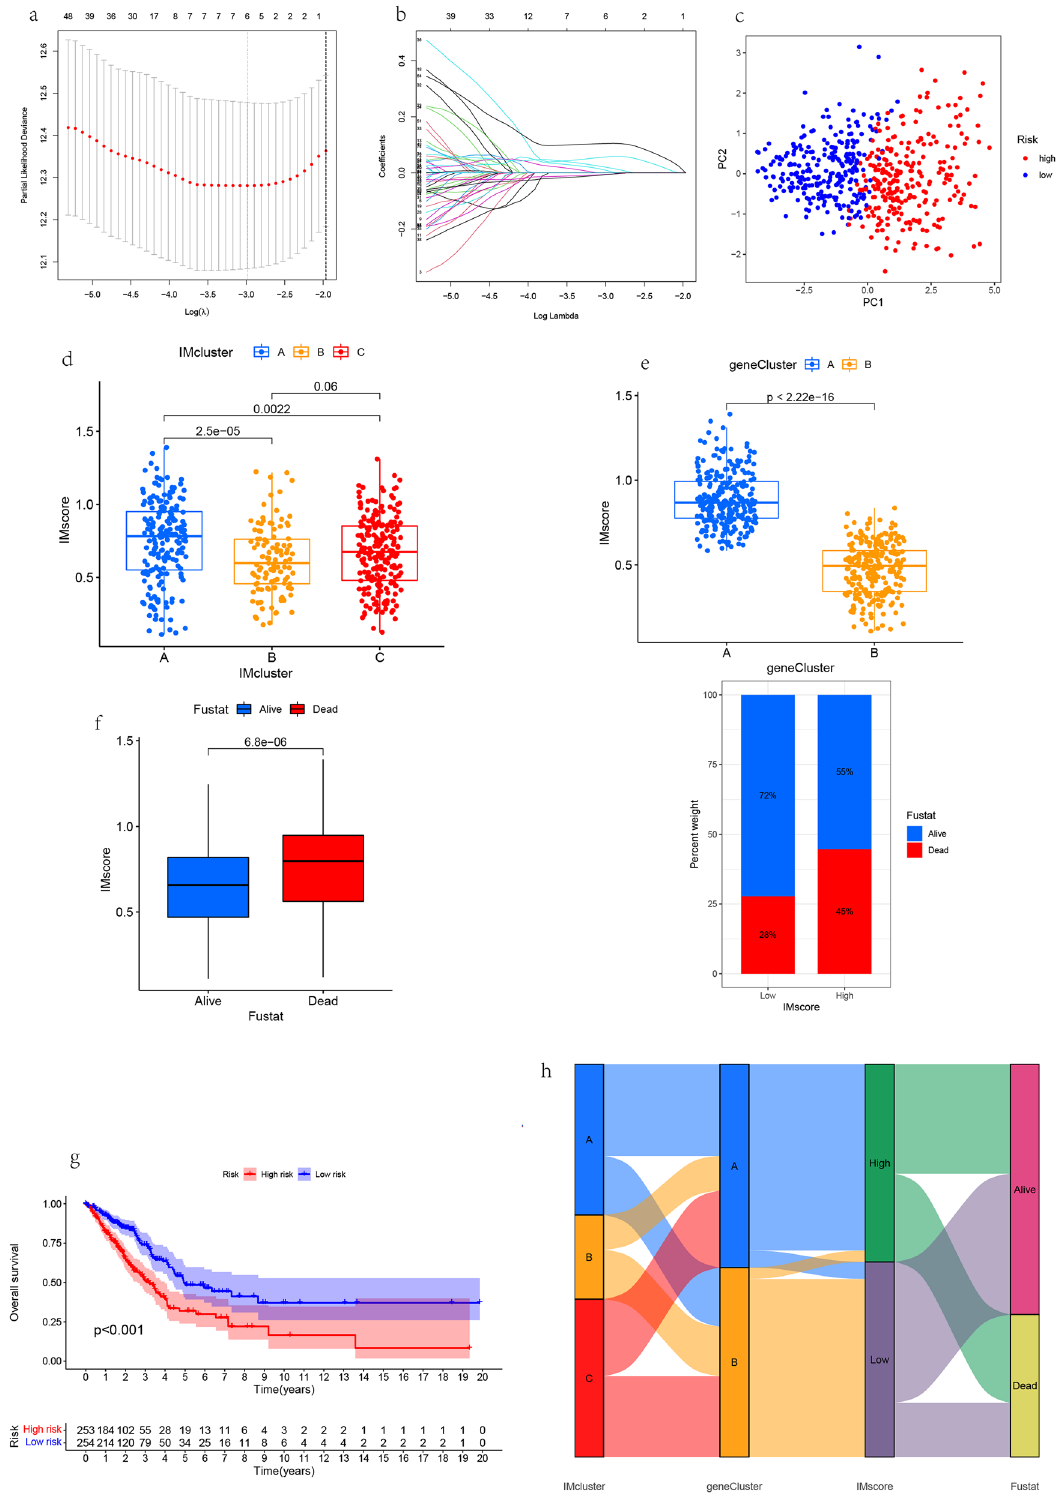
Figure 5. Lasso regression analysis was used to construct prognostic gene features. ( a ) Least absolute shrinkage and selection operator (Lasso) coefficient spectrum of 6 potential prognostic genes related to immunity. ( b ) The best parameters in lasso regression were selected by 10 × cross validation. Lasso, min imum absolute contraction and selection operator Cox regression model. ( c ) Principal component analysis (PCA) showed the sample distribution of different risk score groups. ( d ) IMscore among different cluster. ( e ) IMscore among different genecluster. ( f ) The relationship between IMscore and survival status. ( g ) Kaplan Meier OS curve between high risk group and low risk group (P < 0.001). ( h ) Sankey diagram showing the relationship between IMcluster, genecluster, IMscore, and survival